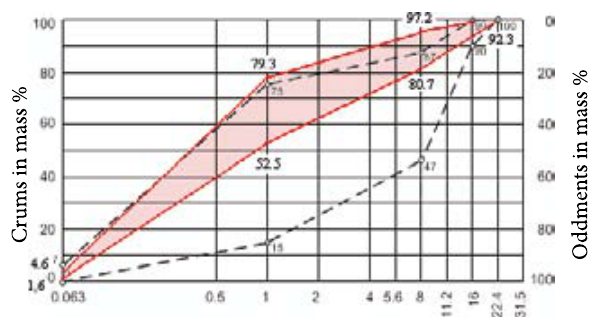
fig. 4. Grading of 0/16 sand mix used for the shoulders These mixes lack not only the gravel fraction 4/8, but also the fraction 0.5/1. To improve the sand mix 0/16 it would be necessary to add the gravel fraction (> 2 mm) and to increase the amount of fines. The sand mix of the existing grading is water permea- ble. The shoulder structure erected from this mix could be tion in mix grading and in shoulder moisture has the influ- ence on the variation in the strength of shoulder pavement and shoulder base.